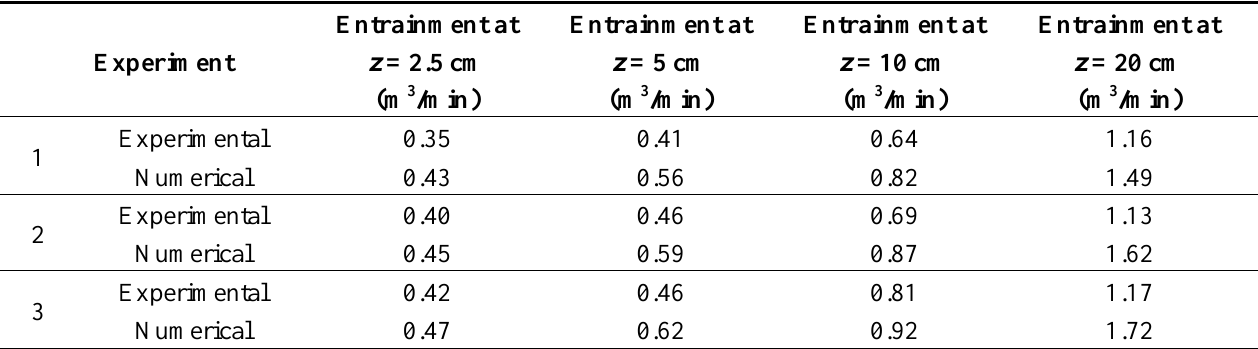
Table 4. The experimental and numerical volume flow rate for all three experiments.